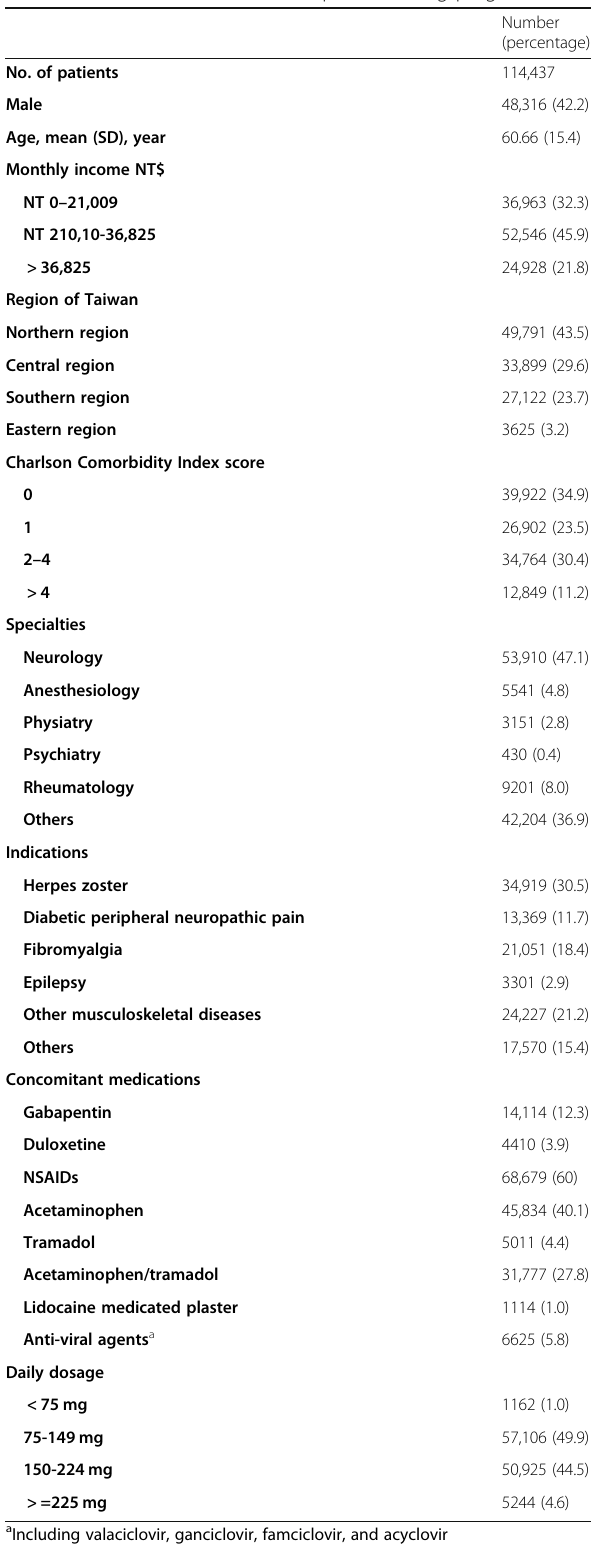
Table 1 Baseline characteristics of patients using